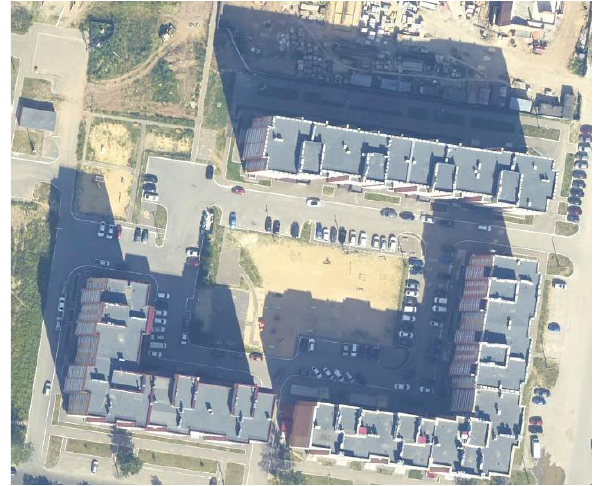
Figure 8. An example of good details elaboration in shadows in aerial image Methods of information loss assessment in shadows and illumination: visually on image, numerically in histogram by minimum or maximum possible pixel value’s outliers.